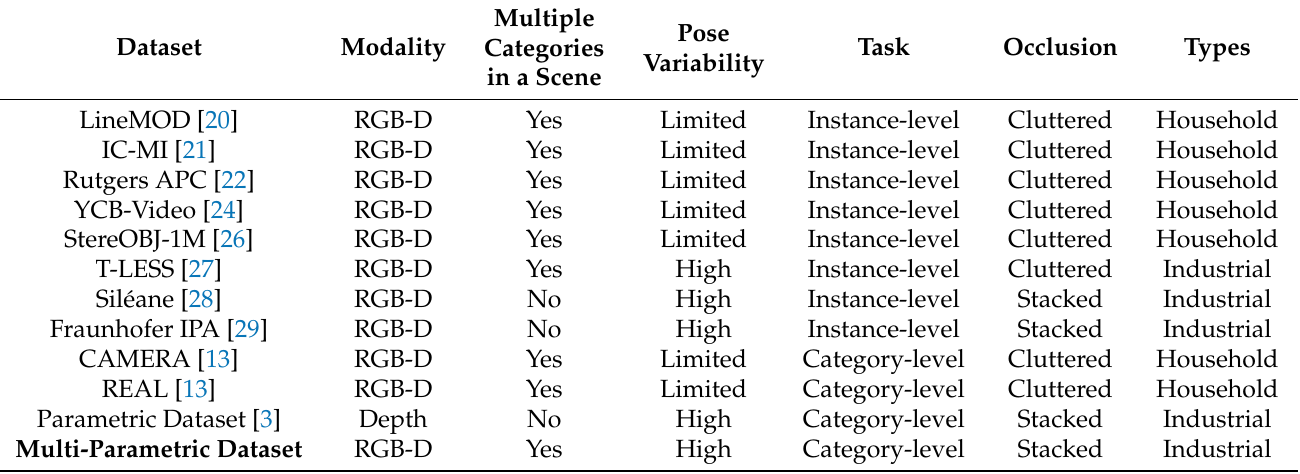
Table 1. Comparison of public